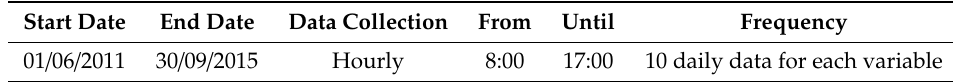
Table 2. Temporary period for data collection for study.